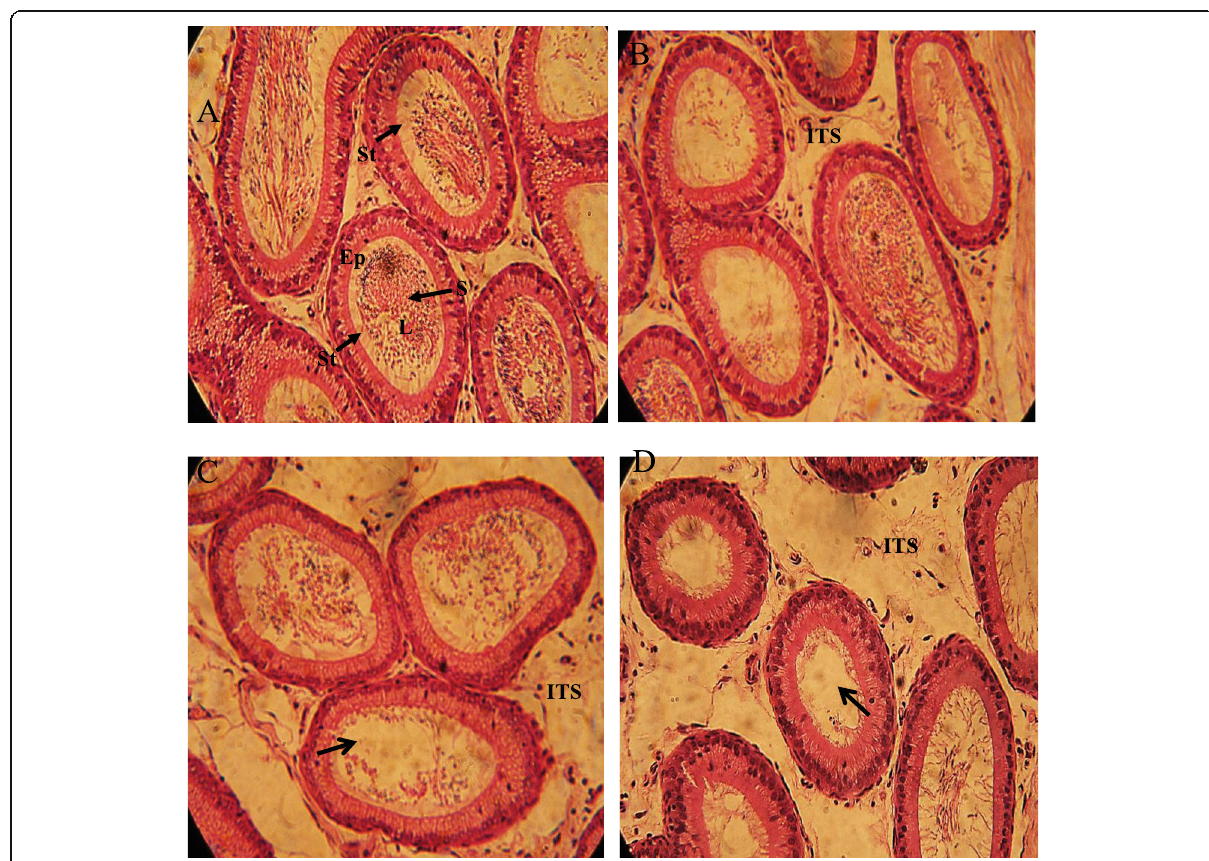
Fig. 2 Photomicrograph of caput epididymis tissue showing ( a ) control; with a compact arrangement of caput tubules with sperm filled lumen ( b ) BPS (0.5 μ g/L)-exposed group, presenting normal caput tubules like in the control ( c ) BPS (5 μ g/L)-exposed group, presenting seminiferous tubules with less number of sperm in the lumen (arrow) ( d ) BPS (50 μ g/L)-exposed group presenting caput tubules with an empty lumen (arrow) empty lumen. H&E (×